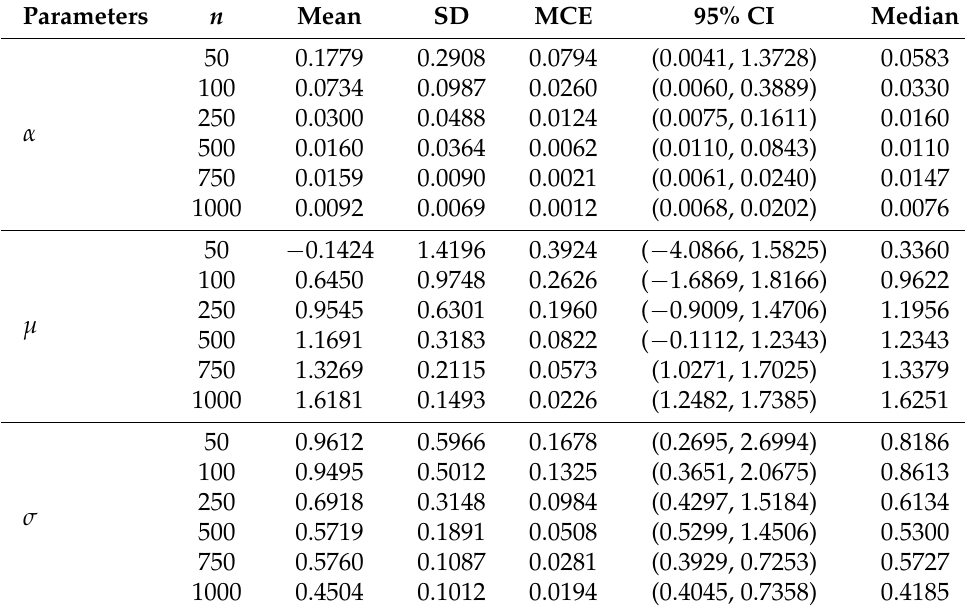
Table 8. Posterior summary results for ( α = 0.01, µ = 1.5, σ = 0.5).